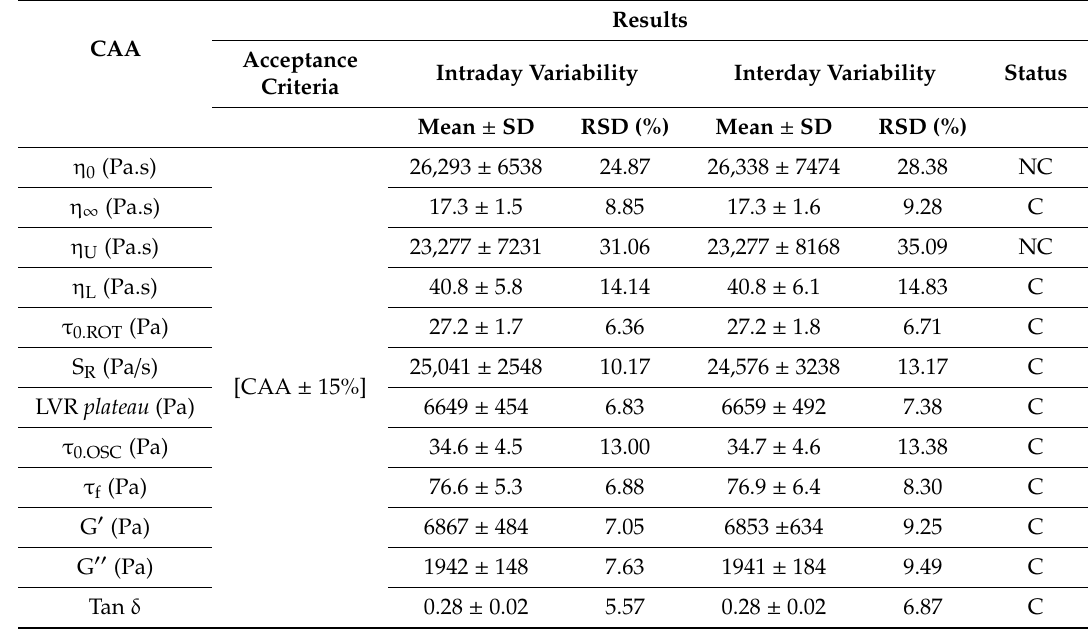
Table 3. Acceptance criteria and results of precision evaluation. Results report to a n =